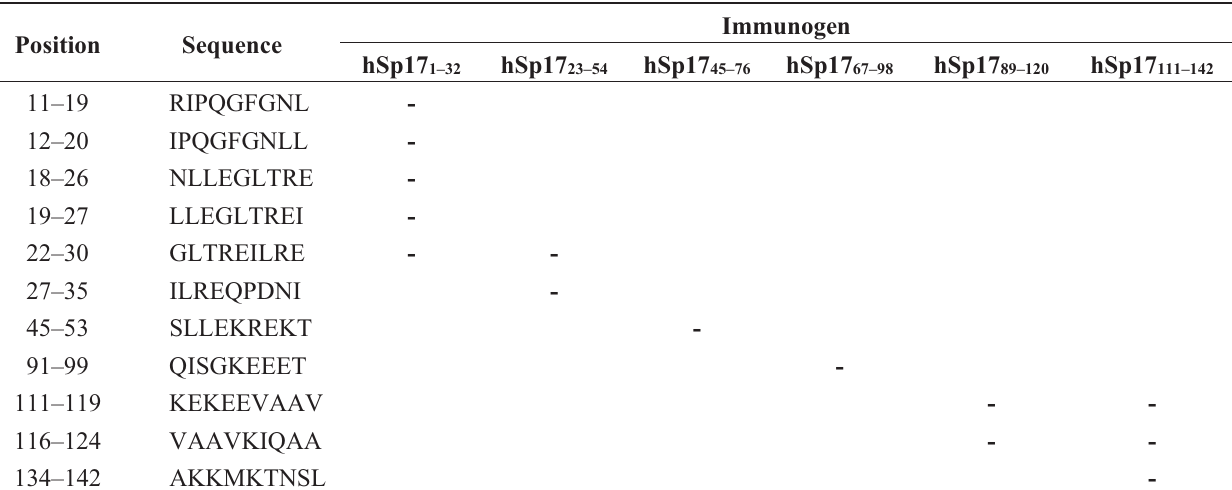
Table A2. Screening for potential HLA-A2.1 restricted CD8 T cell epitopes in hSp17 peptides conjugated to PSNPs in HLA-A2.1